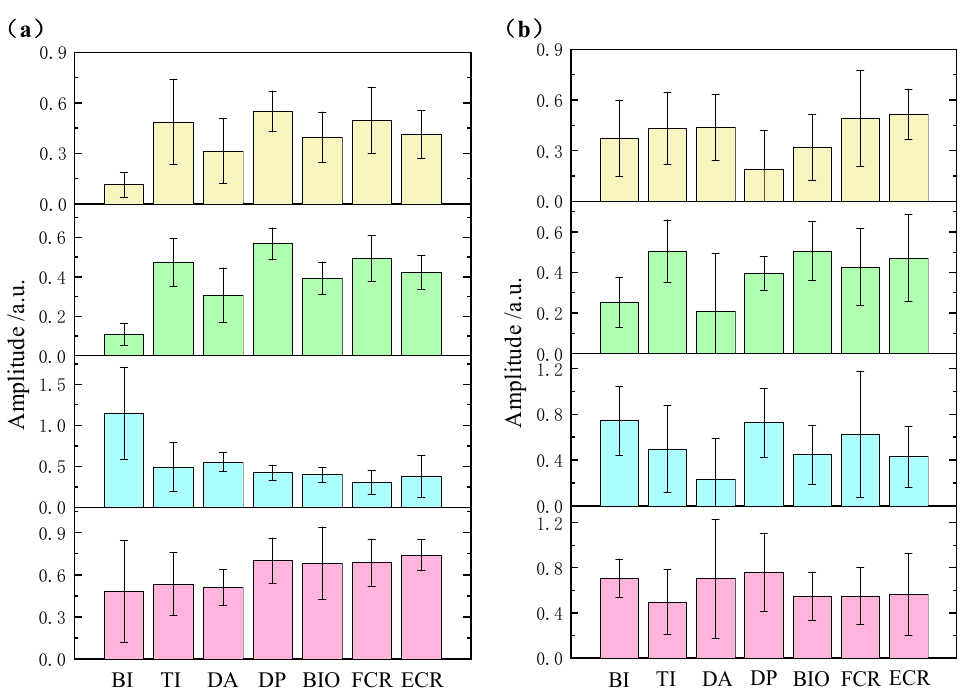
Figure 7. The statistical chart of synergies extracted by MCR-ALS ( a ) and NMF ( b ) from a typical stroke subject.